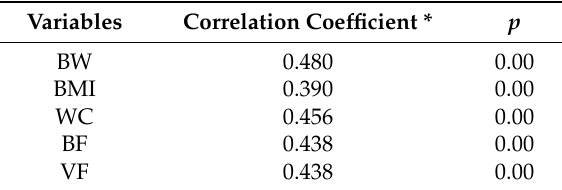
Table 2. Correlation of IR with Several Indices of Obesity.